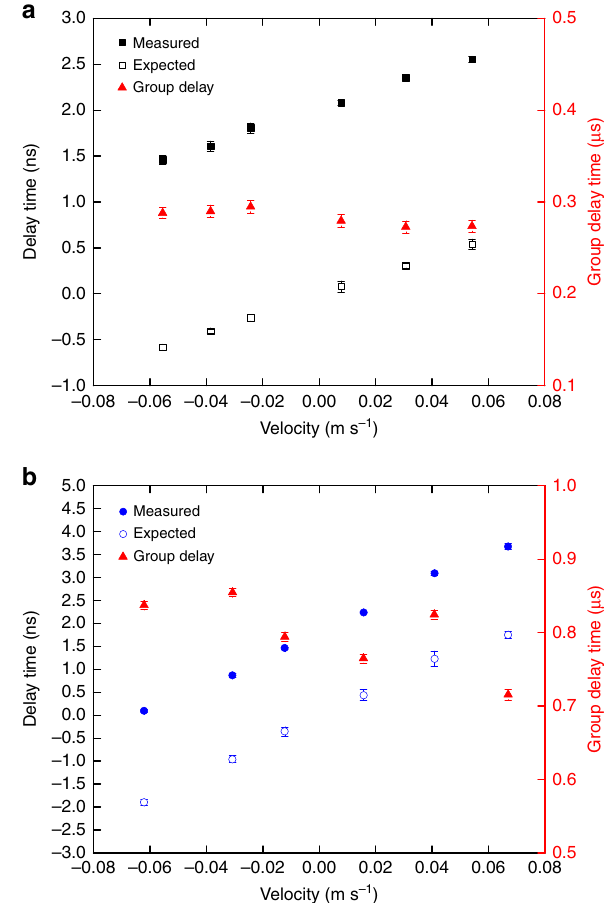
Figure 3 | Phase and group delays of the probe field versus velocity of the atomic ensemble. ( a ) With control field power of 2mW. The black solid squares are the measured phases and the black open squares are the expected phases (left axis) from equation 4 and group delay measurements. ( b ) With control power of 0.6mW. The blue solid circles are the measured phases and the blue open circles are the expected phases (left axis) from equation 4 and group delay measurements. The red solid triangles are the group delay times (right axis). The phase delay are measured in terms of the delay time. One cycle corresponds to 1/70MHz ¼ 14.29ns. The measured phase uncertainty is by taking the standard error of three cycles of 70MHz sinusoidal wave in the probe field envelope and averaging for 20 experimental cycles. Each experimental cycle takes 2s. The group delay of the probe field is measured at each velocity by fitting the center of the probe field pulse with a Gaussian function.